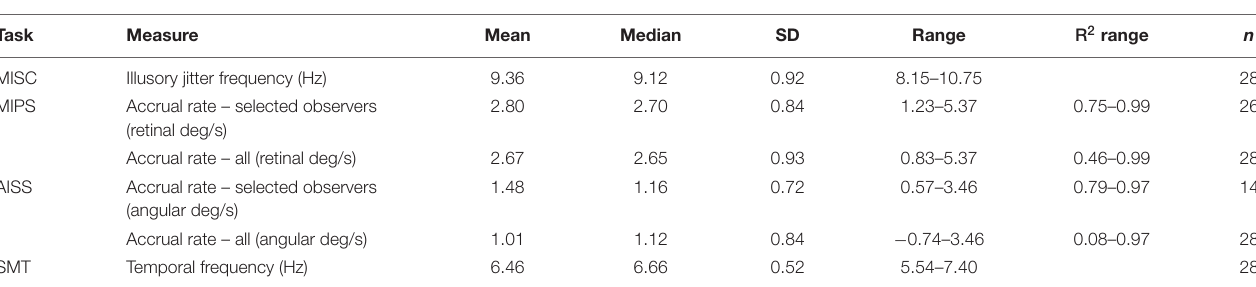
FIGURE 2 | An illustration of one participant’s data in all four tasks. In (A) MISC, the percentage of trials for “perceiving physical jitter faster” is plotted as a function of physical jitter frequency. Logistic functions [ y = 1/(1+exp( a -x)/ b )] were fitted to the data, using a least squares method. The PSE and slope, which are a and b in the function, represent the illusory jitter frequency and participant discrimination performance, respectively. In (B) MIPS and (C) AISS, the magnitude of the illusion (mean and standard deviation based on the data of all test runs) is plotted as a function of stimulus duration or T-C interval. A linear model ( y = B0 + B1 × t) was used to fit the first five mean values (0–83 ms) in MIPS and all the mean values in AISS. The B1 stands for the accrual rate of the illusion in the model. The R-squared and p -value in the regression analysis are shown in the figure. Note that the unit of the illusion ( ◦ ) is retinal degrees in MIPS and angular degrees in AISS, respectively. In (D) SMT, the analysis method was the same as for MISC, except that the percentage of trials for “perceiving perturbed motion” is plotted as a function of stimulus temporal frequency, and the PSE indicates the smooth motion threshold. Also see Figure 1 and Table 1 . TABLE 2 | Descriptive statistics for all